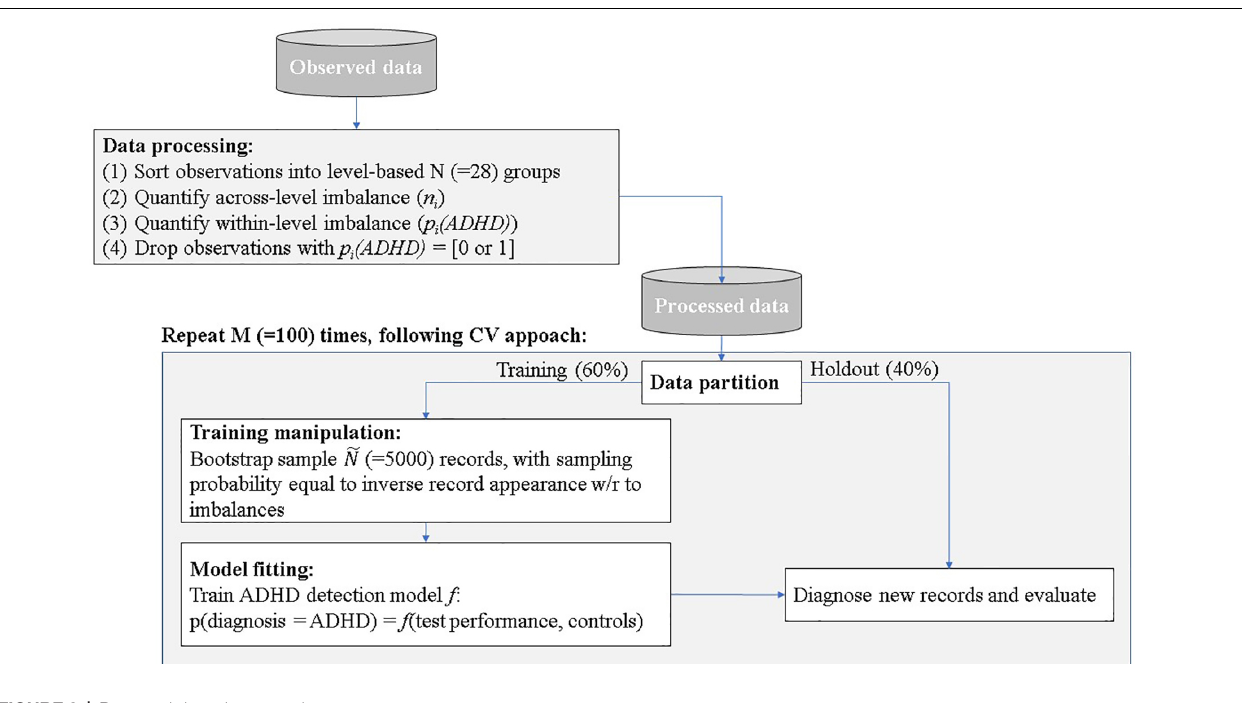
FIGURE 3 | Proposed detection procedure.